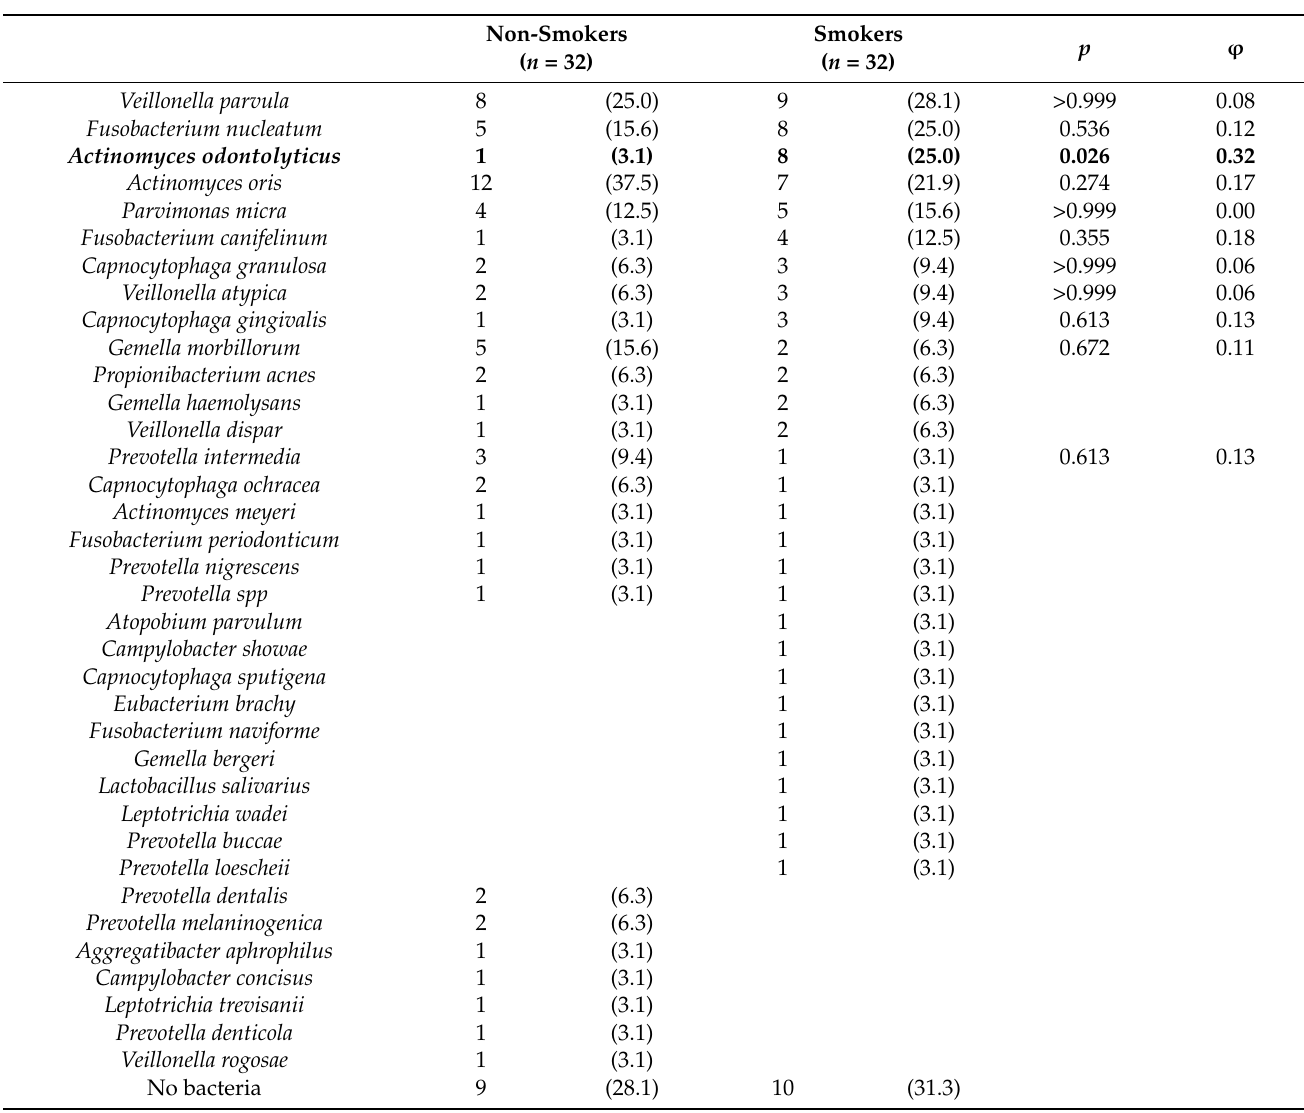
Table 3. Prevalence of anaerobic